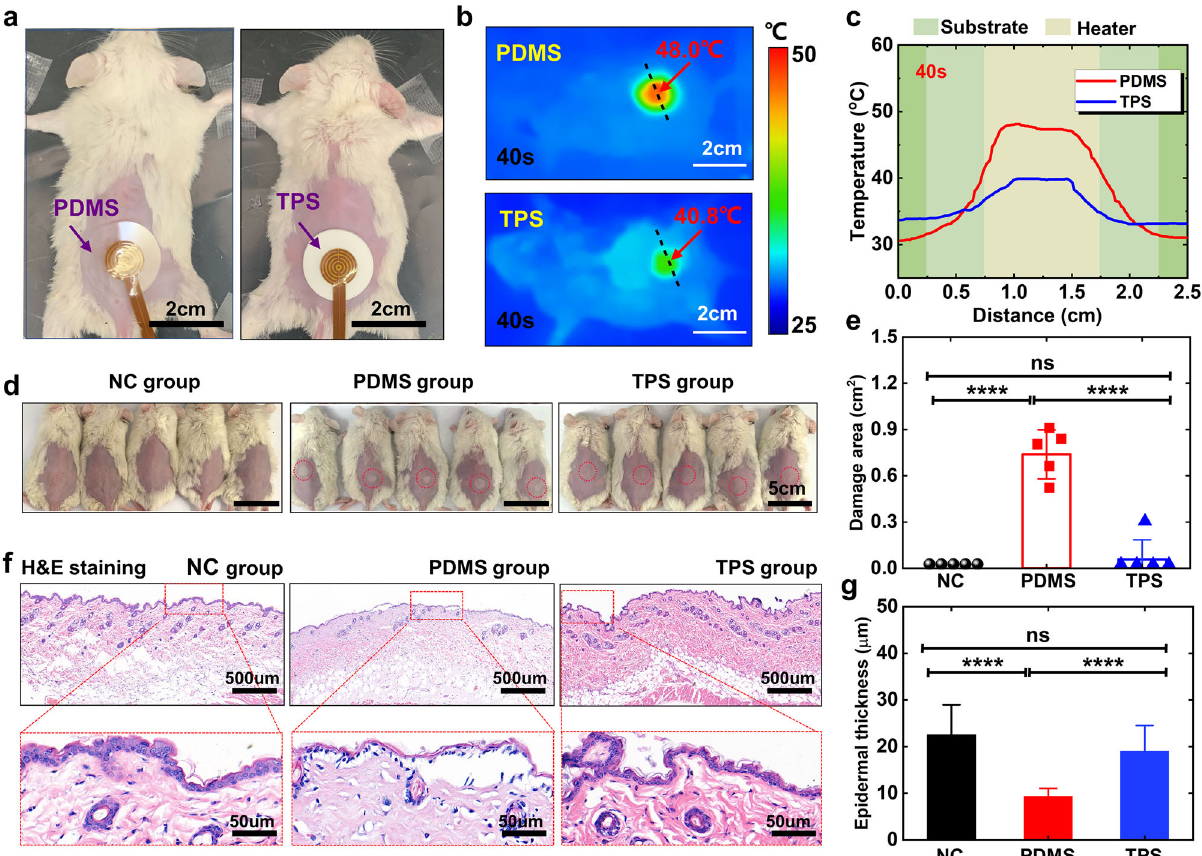
Fig. 4 Animal experiment of thermal protection for the skin. a Photos of wearable heaters with the PDMS substrate (left) and TPS (right) attached to the mice skin. b Thermal images of the mice skin after heating for 40 s. c The temperature change along the dotted line in Fig. 4b. d Photos of mice after experimenting in NC (left), PDMS (middle), and TPS (right) group. e The area of damaged skin in NC, PDMS, and TPS group. f Hematoxylin-eosin (H&E) staining of mice skin in NC (left), PDMS (middle), and TPS (right) group. g The epidermal thickness in NC, PDMS, and TPS group. The thickness of the substrate is 1.3 mm and the heating power is 445